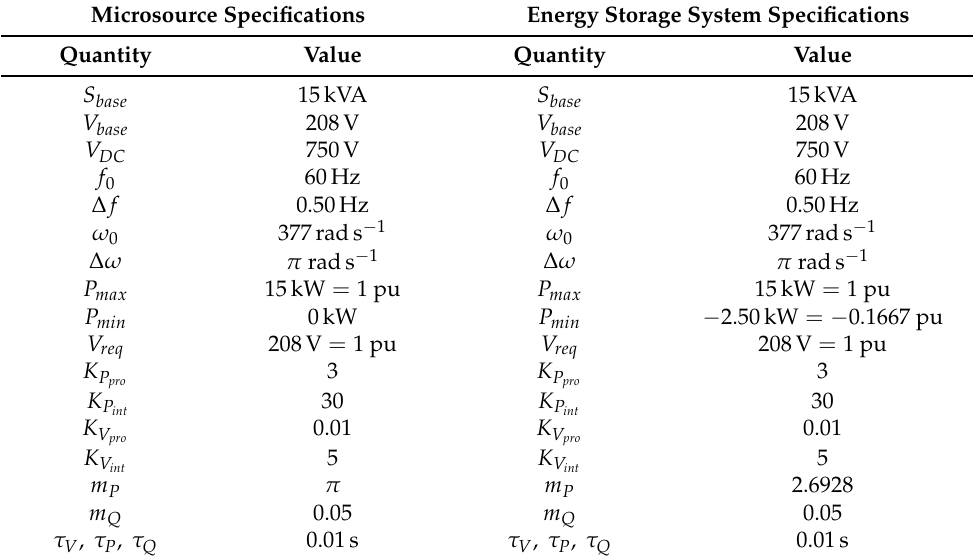
Table A3. Specifications of the inverter-based microsource and energy storage system.